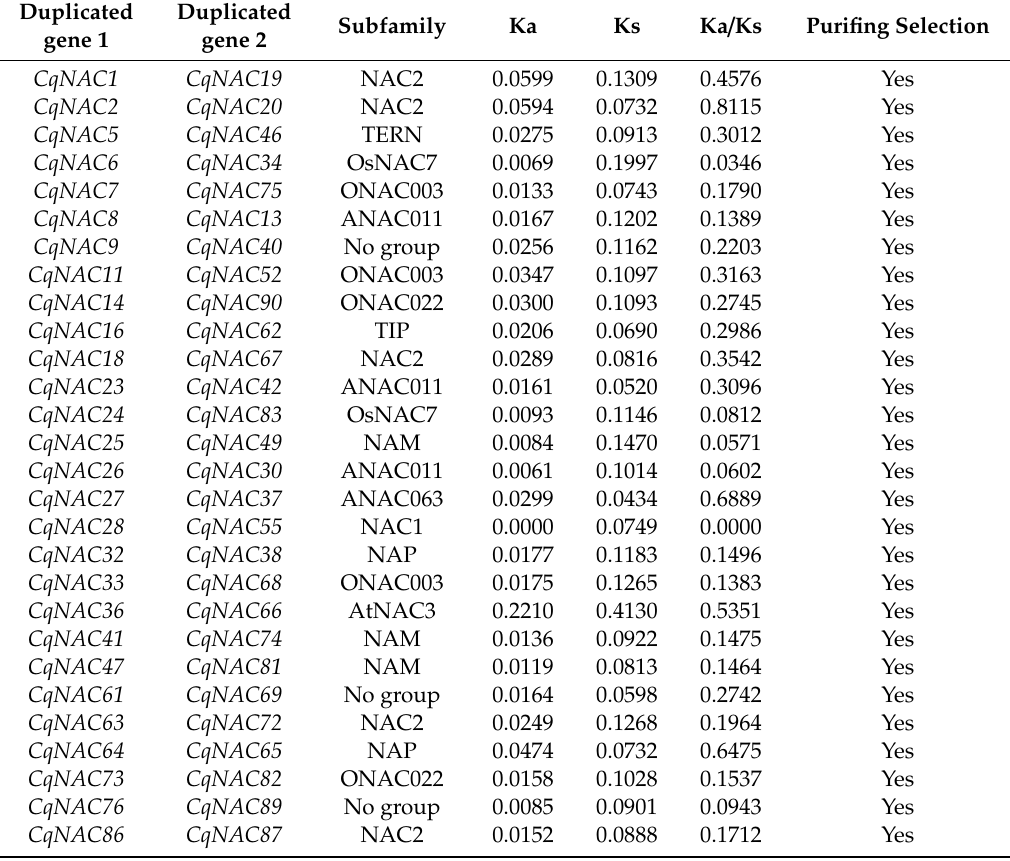
Table 1. Ka / Ks analysis for duplicated gene pairs of NACs in